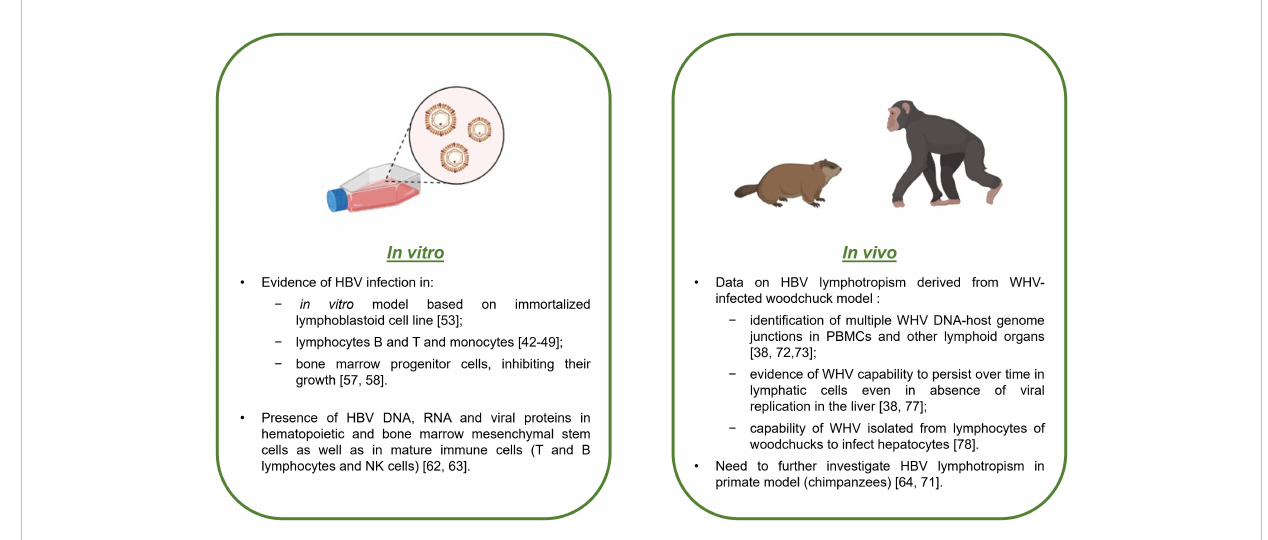
FIGURE 2 Evidence of HBV infection in lymphoid cells from in vitro and in vivo studies. Schematic summary with the main results of HBV infection in lymphoid cells based on cell cultures and animal